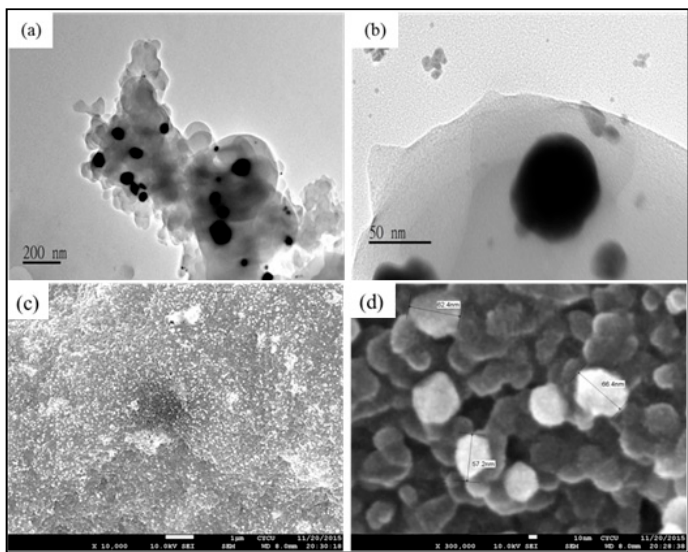
Figure 4. ( a , b ) TEM, and ( c , d ) FE-SEM images of the synthesized electroactive PI/AuNPs.